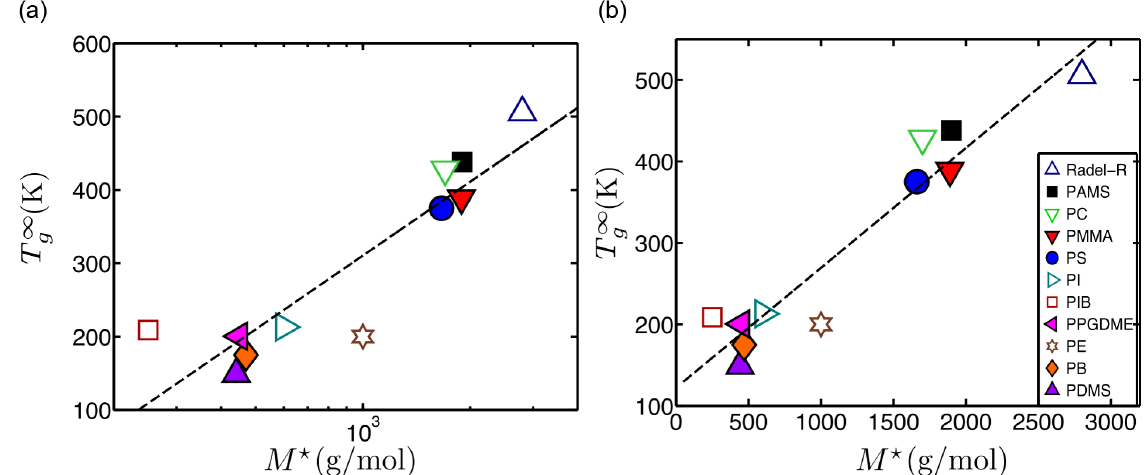
FIG. 13. T ∞ vs M (cid:2) in a (a) semilogarithmic and (b) linear plot. Open symbols denote polymers with less certainty in M (cid:2) due to data g M Þ . that do not cover all three regimes in T g ð